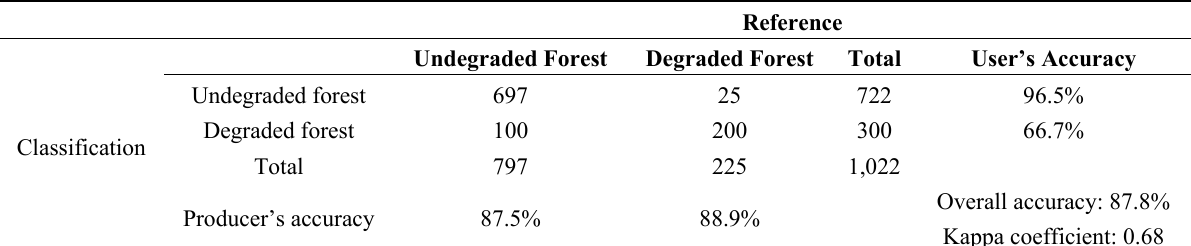
Table 3. Confusion matrix for Cameroon degradation map, 1,022 label points used .